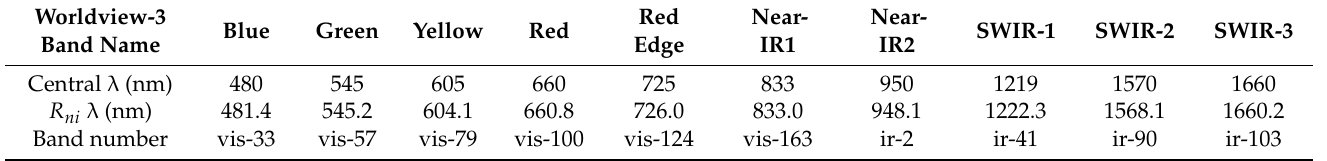
Table 3. Summary of Worldview-3 bands and the closest wavelengths in the hyperspectral dataset with their band index number.